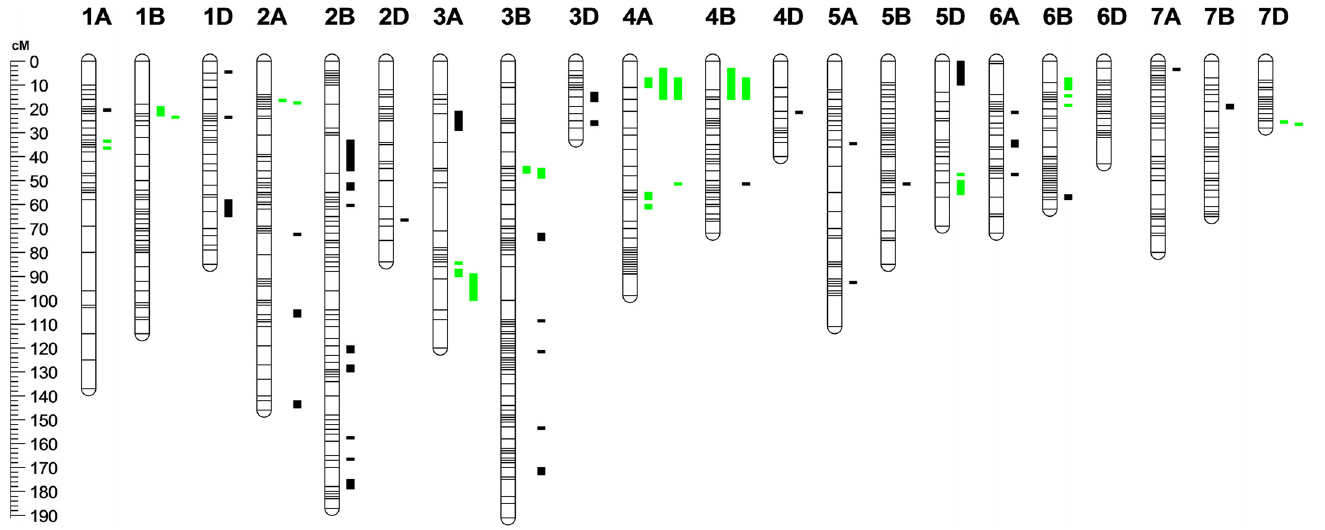
Fig 4. Chromosomes with APR QTL to stem rust detected by the joint inclusive composite interval mapping (JICIM) method. Multiple QTL in green color on a given chromosome are hypothesized to be a single